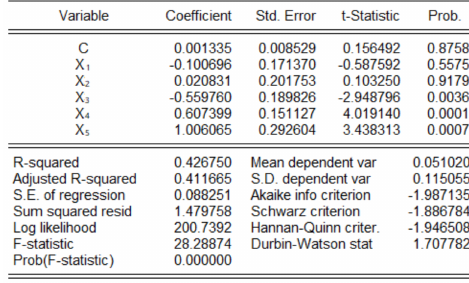
Figure 5. Predictive Model (5) first test